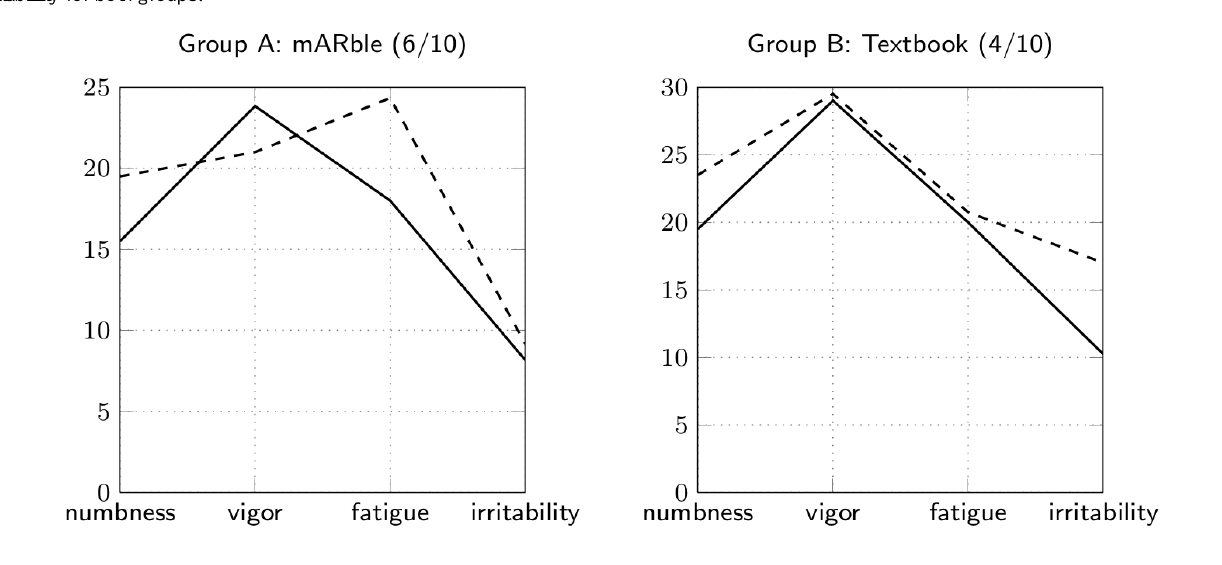
Figure 7. Learning affection: pre-test (dashed line) and post-test (solid line) comparison of the aggregated values for numbness, vigor, fatigue, and irritability for both